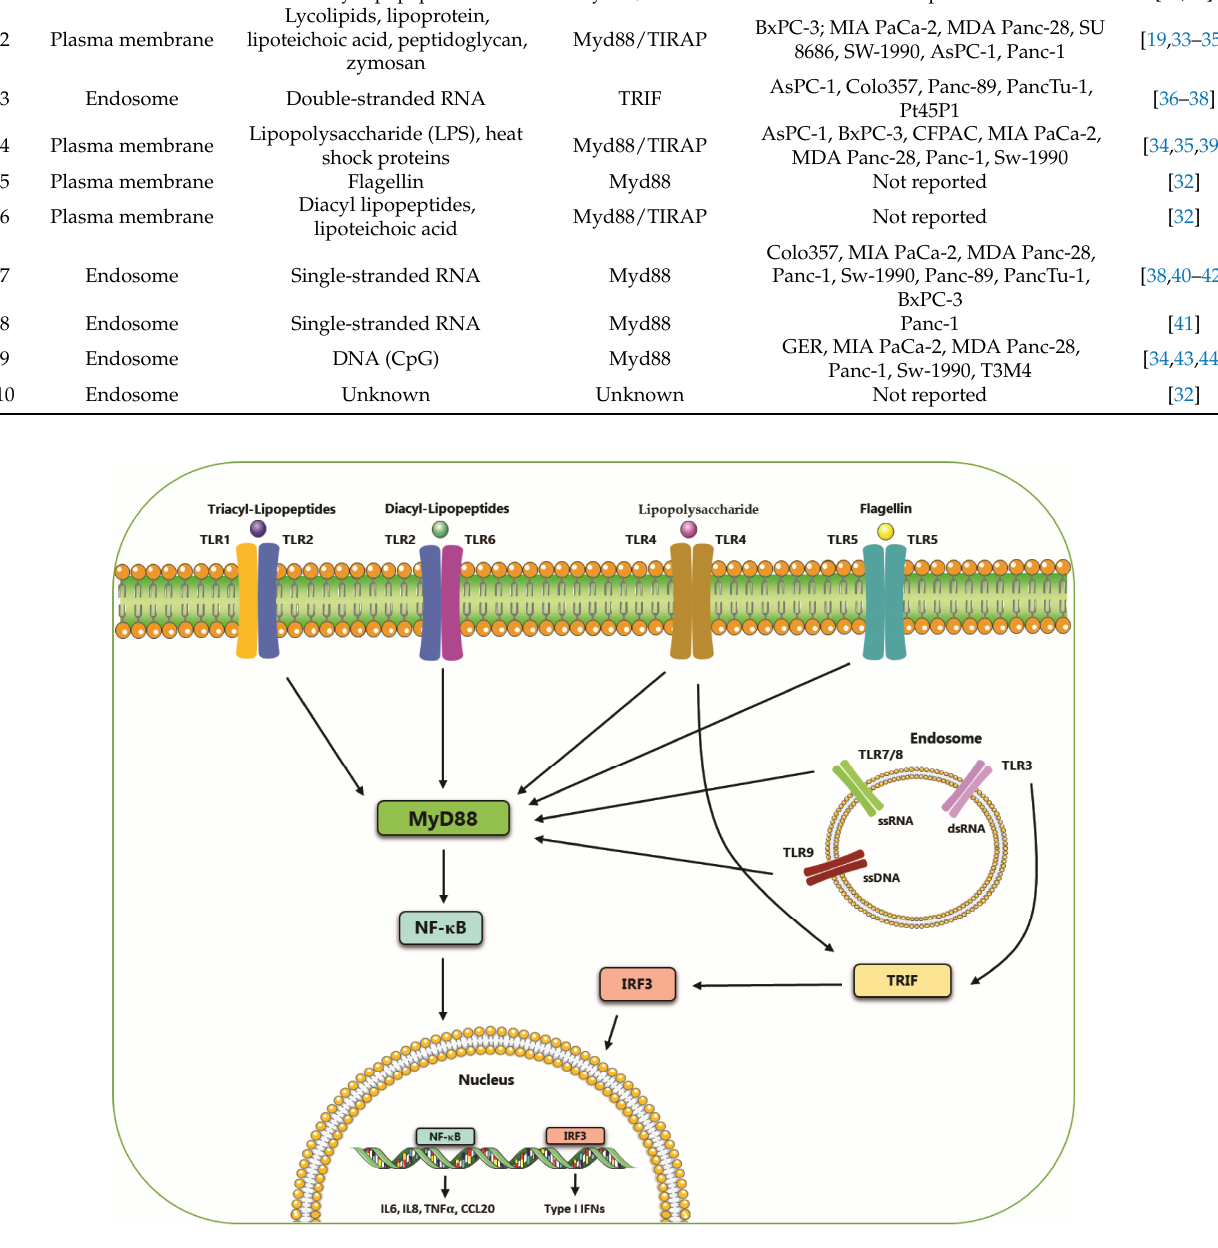
Figure 1. Localization and ligands of toll-like receptors (TLRs). The surface-expressed TLRs recognize bacterial compounds while the intracellular receptors recognize virus-associated nucleic acids. Almost all these receptors activate a signaling pathway that, through Myd88, leads to the activation of the transcriptional factor NF-κB. TLR3 and TLR4 activate a Myd88-independent signaling which culminates in the activation of transcriptional factor IRF3. Table 1. Toll-like receptors expressed in human pancreatic cancer cell lines. TLR1 is expressed on the membrane of several lymphoid cell lines, including mono- cytes and lymphocytes and neuronal cells, such as CHP-212 and NT2-N [45,46]. This receptor is able to form a heterodimer with other TLRs acquiring the ability to recognize a broad range of antigens, such as bacterial proteins upon binding to TLR2 [47], and fungi upon binding to TLR6 [48]. Little is known about the role of this receptor in pancreatic